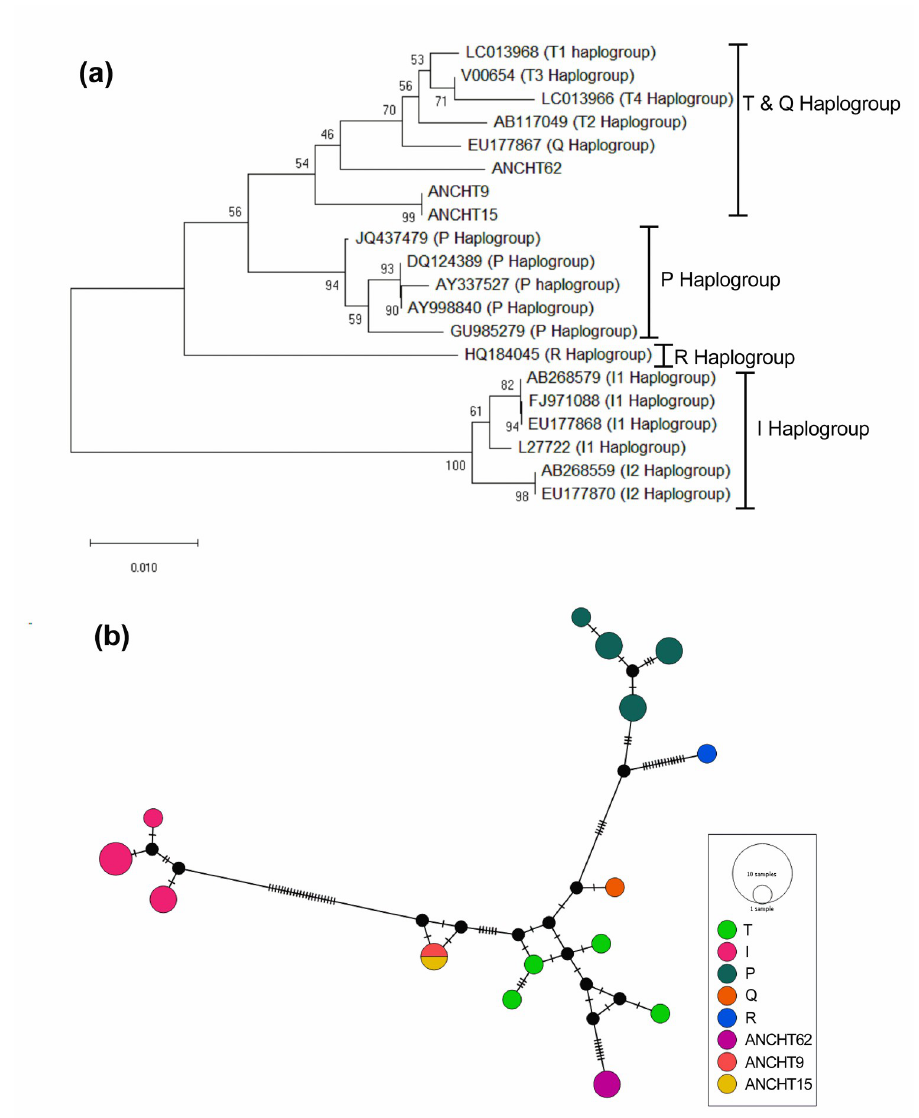
Fig 4. Phylogeny and network map of three Andaman cattle haplotypes (ANCHT9, ANCHT15 and ANCHT62). (a) Neighbor Joining (NJ) phylogenetic tree of the haplotypes with standard cattle haplogroups, (b) A haplotype network map of the haplotypes. The NJ tree was drawn in MEGAX [36] and the network was drawn in PopART ver. 1.7 [42].